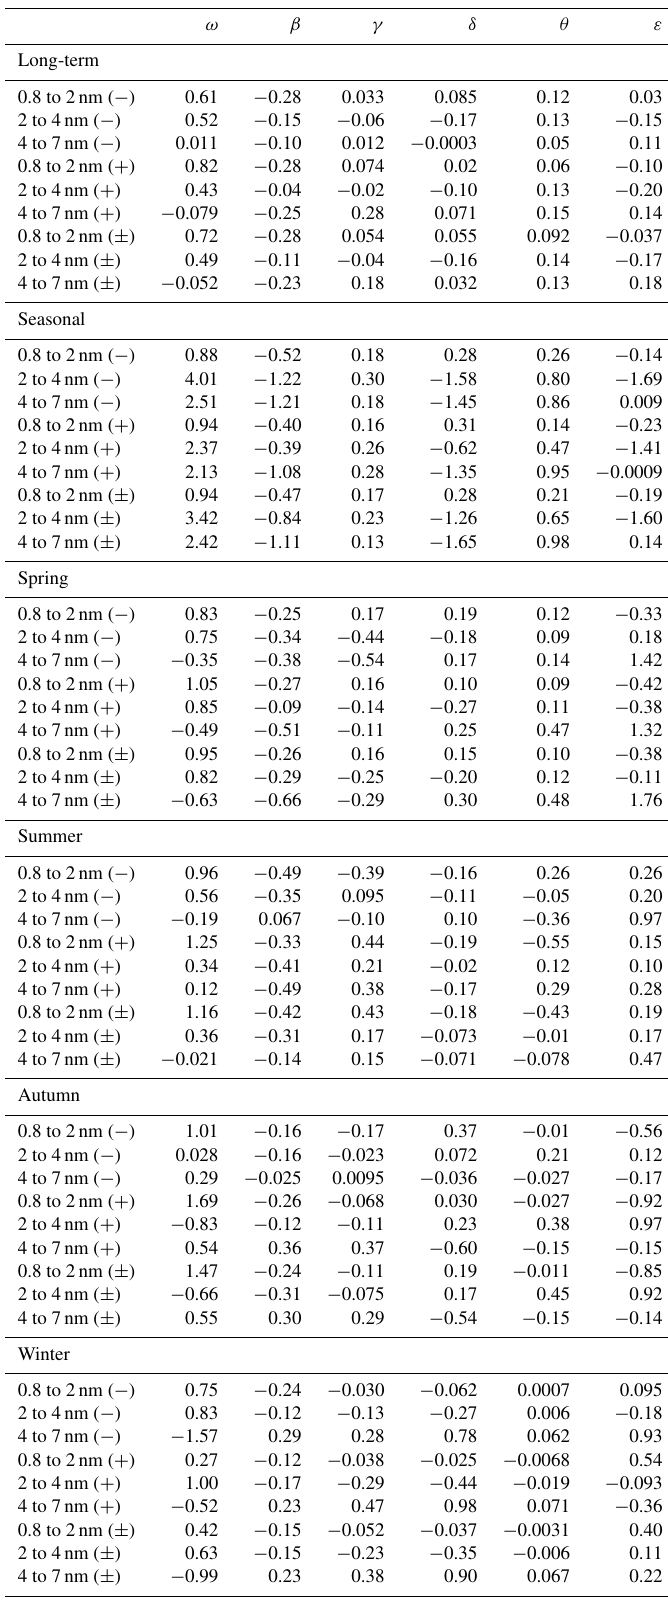
Table A1. The coefficients of the multiple linear regression model used in the